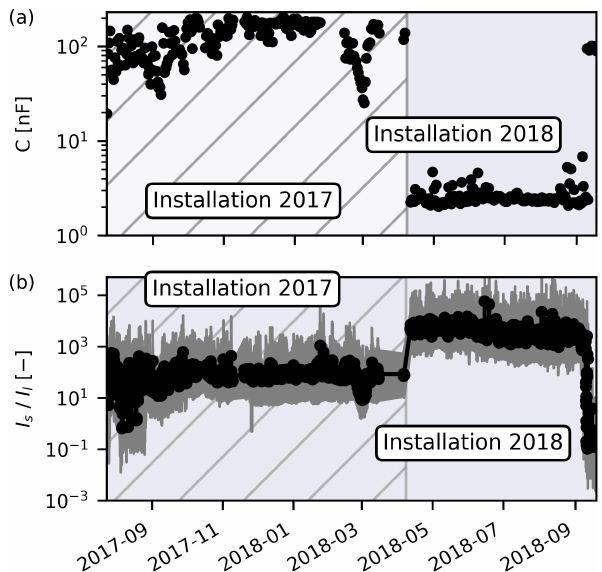
Figure 10. (a) Evolution of daily mean cable capacitances at 1kHz. (b) Evolution of ratio between symmetric injection current and leak- age current, I s /I l , at 1kHz. Dark grey areas indicate the range be- tween minimum and maximum values, and the hatched area indi- cates the time span in which measurements were conducted with the initial electrode and cable